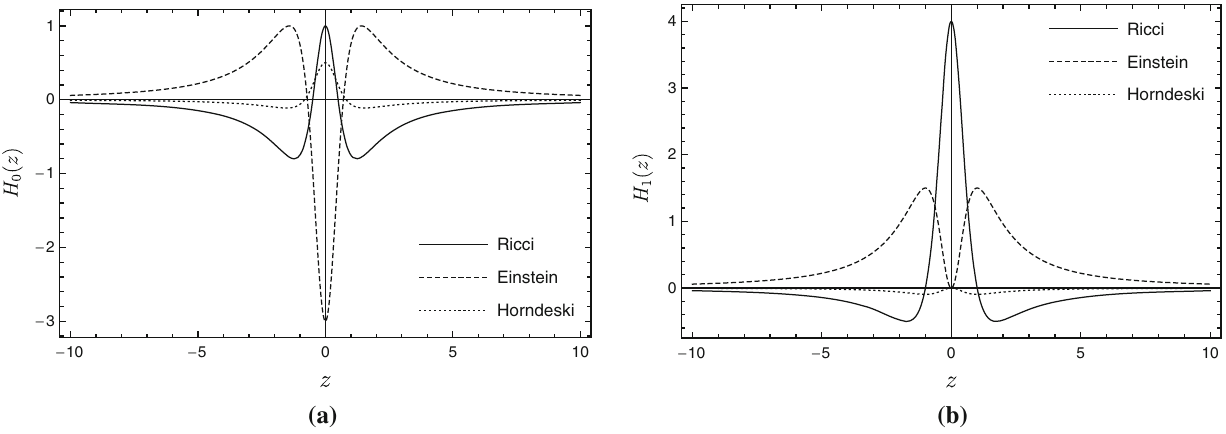
Fig. 5 Transmission coefficient for KR field in brane scenario generated by domain-walls with Riemann tensor coupling as a function of E = m 2 a For some values of n with γ = − 2. b For some values of coupling constant γ with n = 1